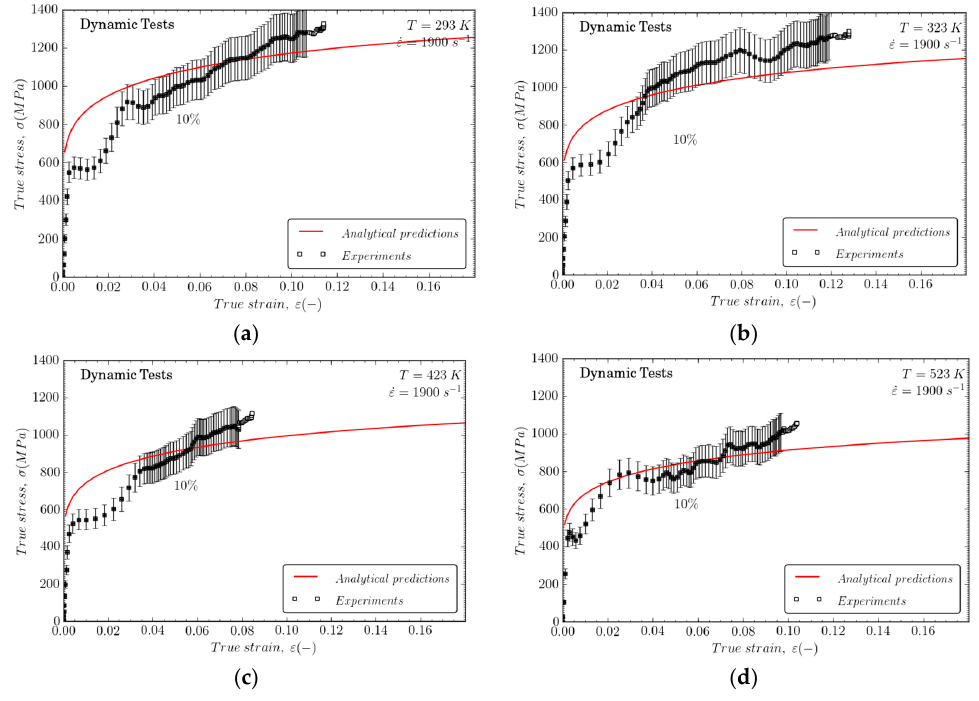
Figure 9. Comparisons between analytical predictions of the constitutive model and experiments at 1900 s − 1 and ( a ) T 0 = 293 K; ( b ) T 0 = 323 K; ( c ) T 0 = 423 K; and ( d ) T 0 = 523 K.